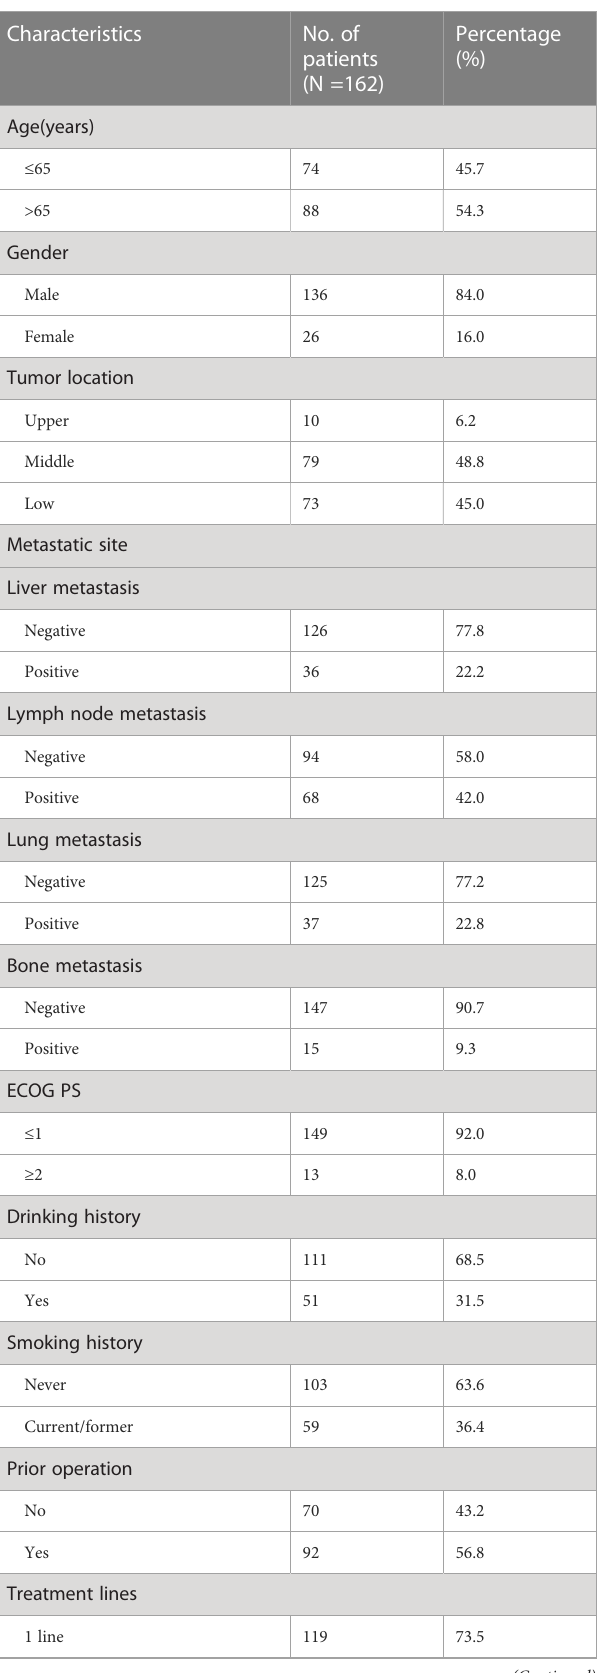
TABLE 1 Baseline characteristics of advanced or metastatic ESCC